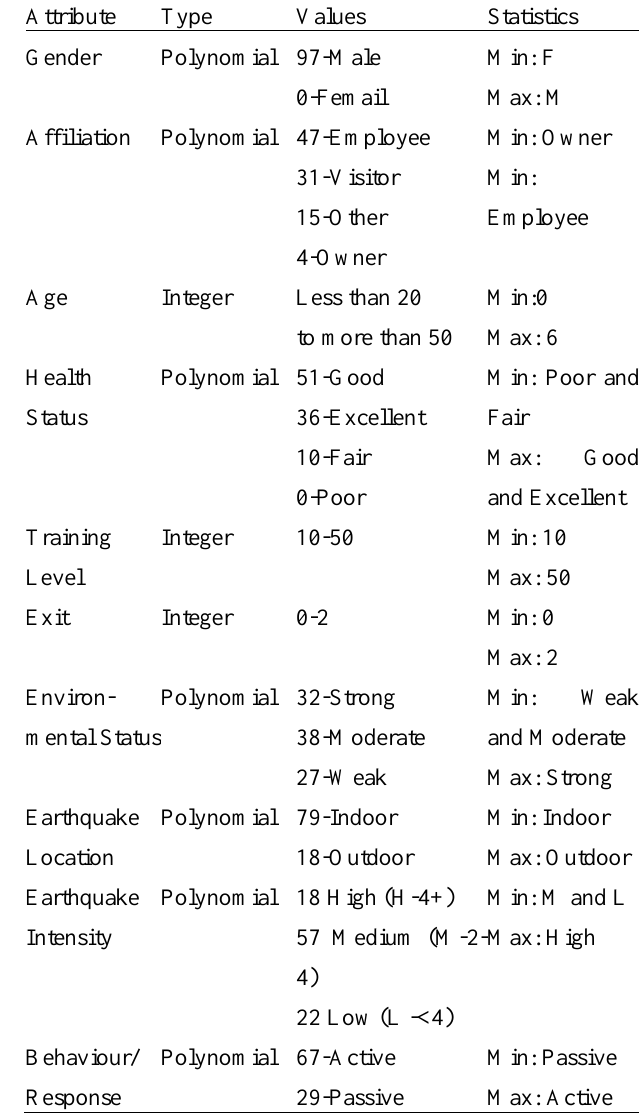
Fig. 1. Proposed crowd behaviour analysis